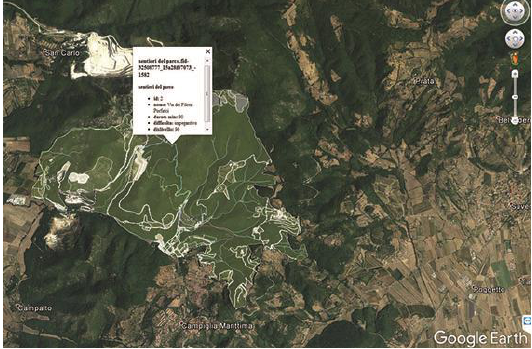
Figure 5. Google Earth view of the Web